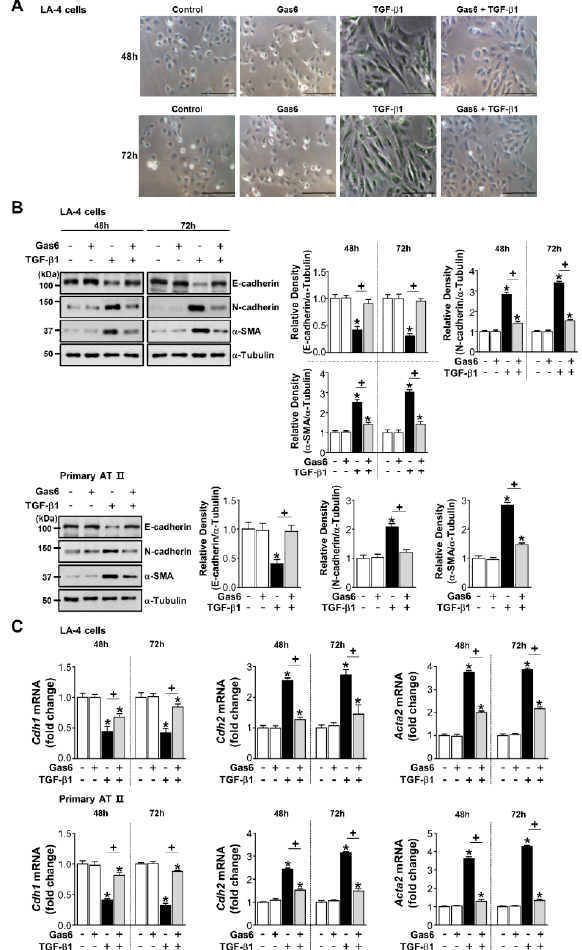
Figure 1. Growth arrest-specific protein 6 (Gas6) pretreatment inhibits transforming growth factor (TGF)- β 1-induced epithelial-mesenchymal transition (EMT) in lung epithelial cells (ECs). ( A – C ) LA-4 and ATII ECs were pretreated with 400 ng / mL Gas6 for 20 h prior to 10 ng / mL TGF- β 1 treatment for 48 or 72 h. ( A ) Morphological changes in LA-4 ECs were examined by phase-contrast microscopy. Scale bars = 50 µ m. Results are representative of three independent experiments. ( B ) Immunoblots of total cell lysates were performed with anti-E-cadherin, -N-cadherin, or - α -SMA antibodies. Densitometry of the relative abundances of the indicated EMT markers. Alpha-tubulin was used as a control. ( C ) The amount of EMT markers’ mRNAs in cell lysates was analysed by real-time PCR and normalized to that of hypoxanthine phosphoribosyltransferase. Values represent the mean ± S.E. of three